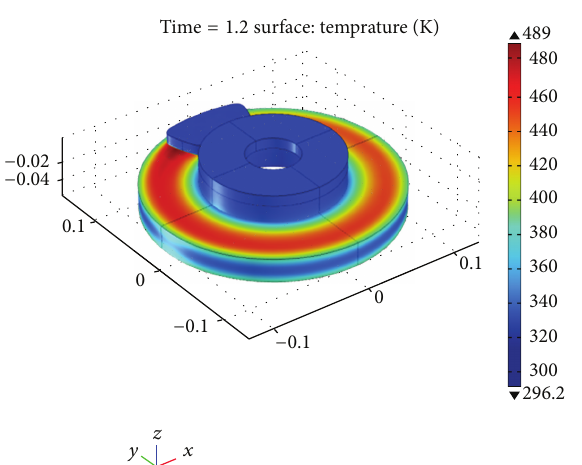
Figure 3: Temperature distribution for GCI disc and aramid pad at 𝑡 = 1.2 seconds.